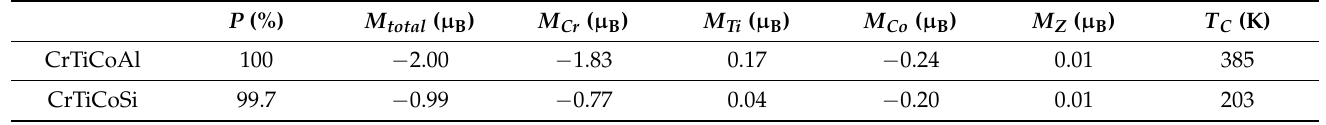
Table 5. Spin Polarization, magnetic moments and Curie temperature of CrTiCoAl and CrTiCoSi